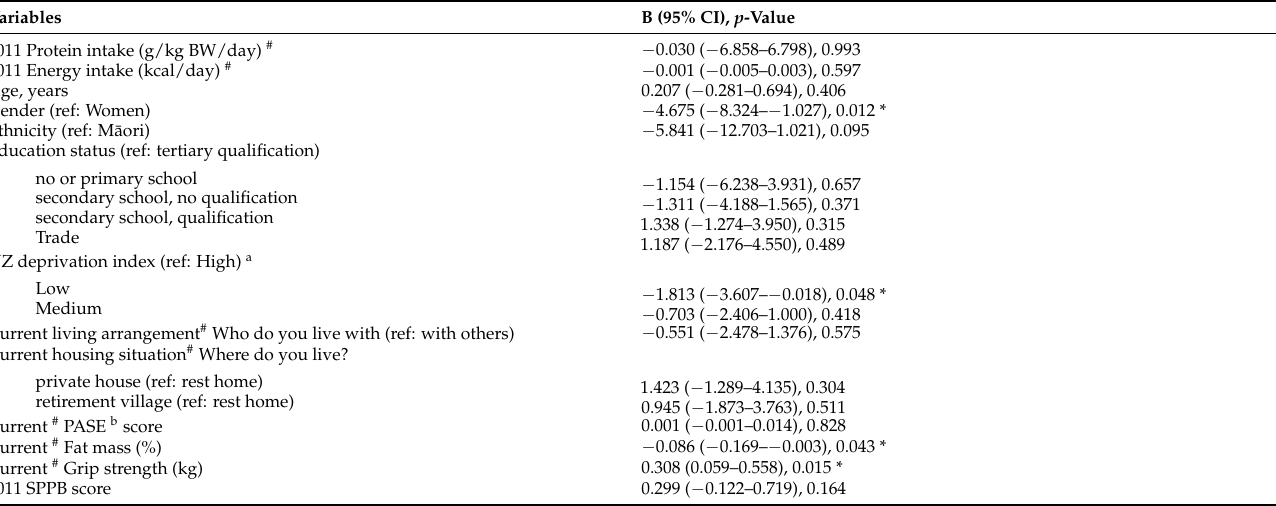
Table 4. Multivariate Regression Model Examining the Relationship between 2011 Protein Intake, as Predictor, and 2021 SPPB Score in all Participants #